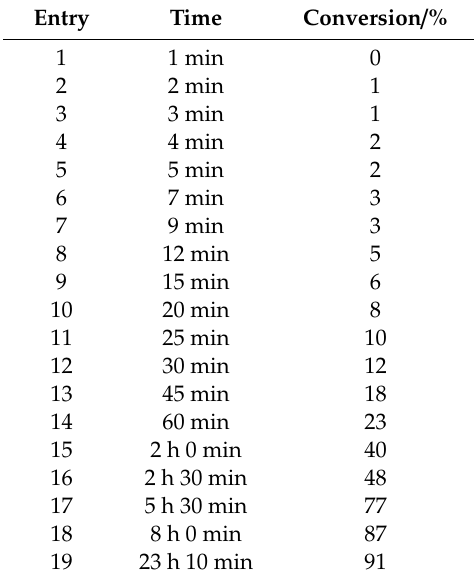
Table A8. Reduction of acetophenone ( 1 ) to 1-phenylethanol ( R )- 2 . Change from standard procedure: bu ff er / solvent ratio 1:2.5 instead of 1:5, adjusted by solvent